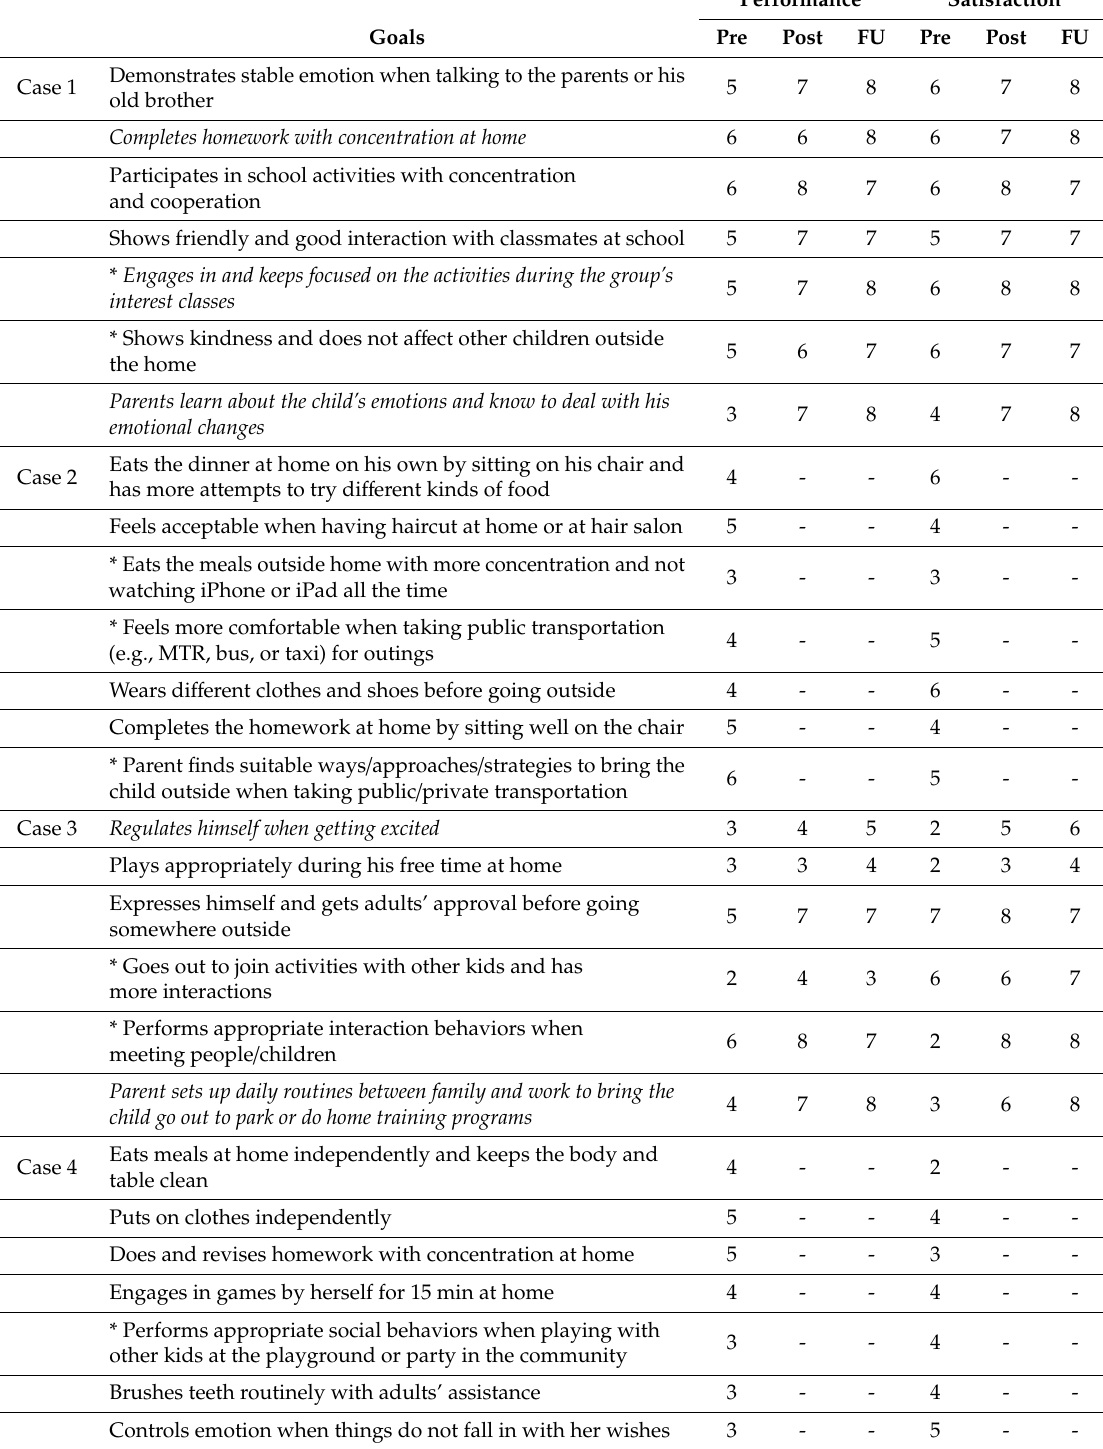
Table 2. COPM scores for parent-identified goals for their children and